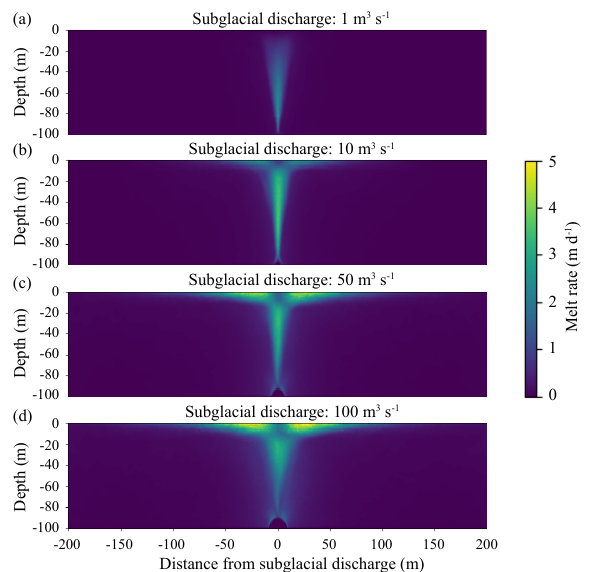
ble an observed crevasse patterns (yellow lines representing crevasses).